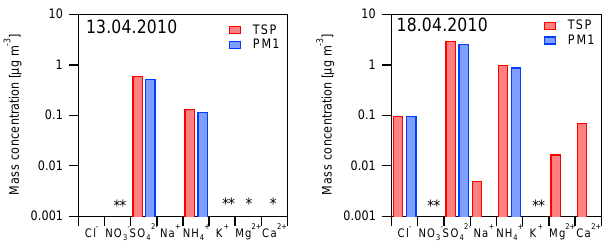
Fig. 4. Ion concentrations in TSP (total suspended particles) and PM 1 . The filters were collected at the Jungfraujoch on 13 April 2010, 00:00–14 April 2010, 00:00UTC+1 (background be- fore plume) and 18 April 2010, 17:10–19 April 2010, 17:10UTC+1 (within volcanic aerosol plume). For nitrate (NO − ) and potassium 3 (**) and partially also for Mg 2 + and Ca 2 + (*), no data is available due to high blank values. SO 2 − : sulfate; NH + : 4 4